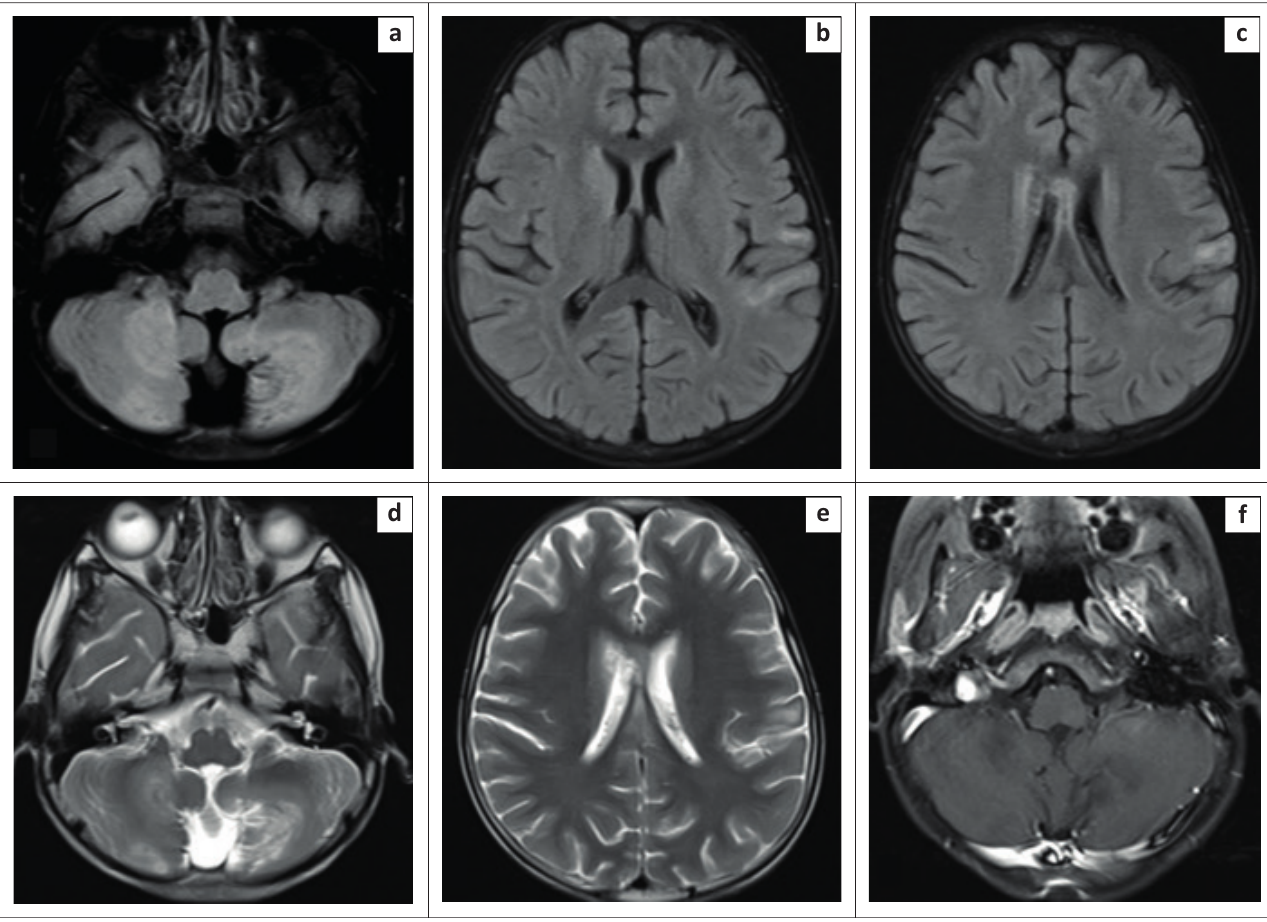
FIGURE 3: [Case 2]: Brain MRI in a 10-year-old male showing multiple patchy FLAIR (a-c) and T2 hyperintense areas of altered signal intensity in the cerebellar hemispheres, left temporoparietal lobe and body of the corpus callosum, (d, e) with no post-contrast enhancement (f). Subtle FLAIR hyperintense signals were also seen in the inferior part of the medulla